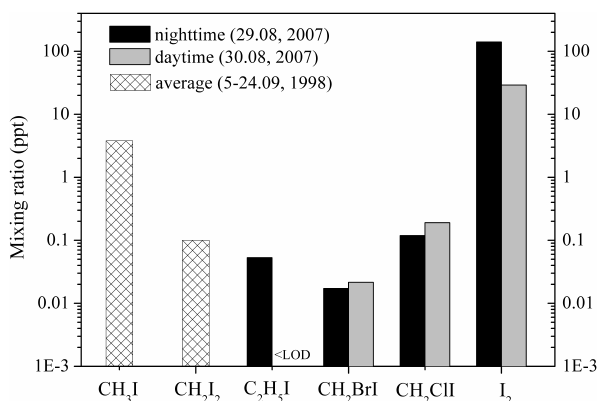
Fig. 4. Typical mixing ratios of reactive organic iodine species and I 2 at Mace Head. The average CH 3 I and CH 2 I 2 mixing ratios dur- ing the 1998 PARFORCE campaign at Mace Head (also given in Carpenter et al., 2003) are included since these two species were not measured during the campaign in 2007. The limits of detection (LODs) for CH 3 I, C 2 H 5 I, CH 2 BrI and CH 2 ICl are 0.2, 0.1, 0.02 and 0.04ppt, respectively. The bar is missing if the mixing ratio is below the LOD. Note the logarithmic scale.